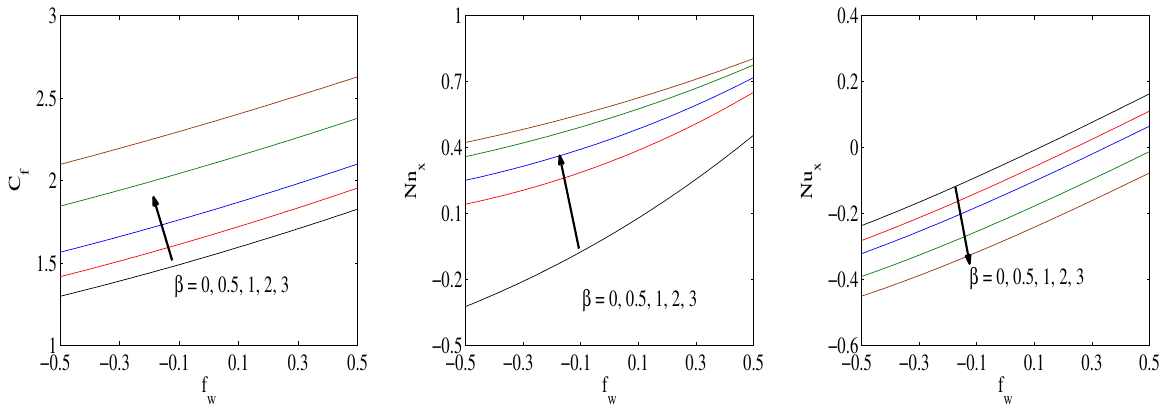
Figure 9. C f , Nn x and Nu x under the impact of β